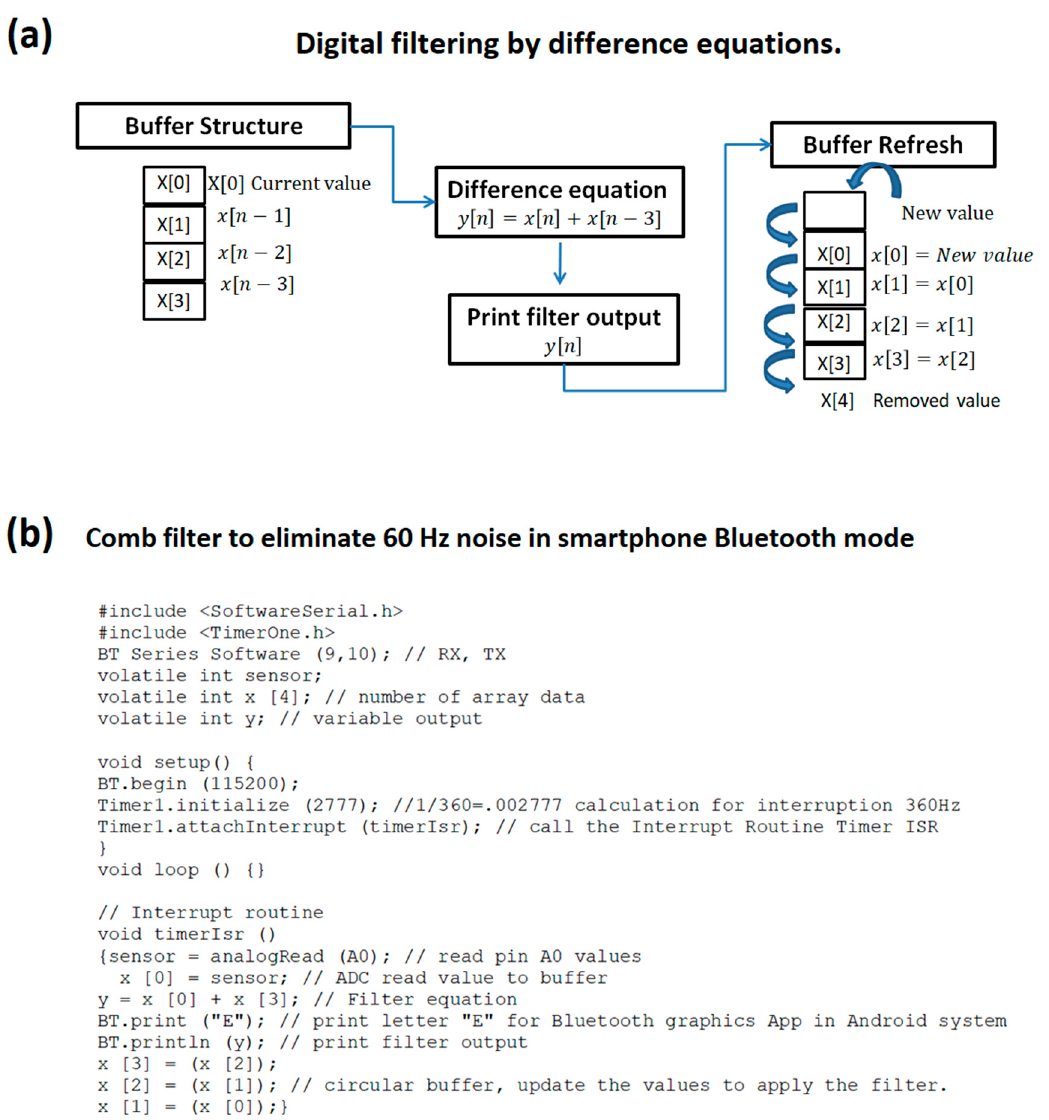
Figure 8. ( a ) Circular buffer for digital filter y[n] = x[n] + x [n − 3]; ( b ) code to implement the digital filter with difference equation on the Arduino platform, Bluetooth transmission, and smartphone visualization.